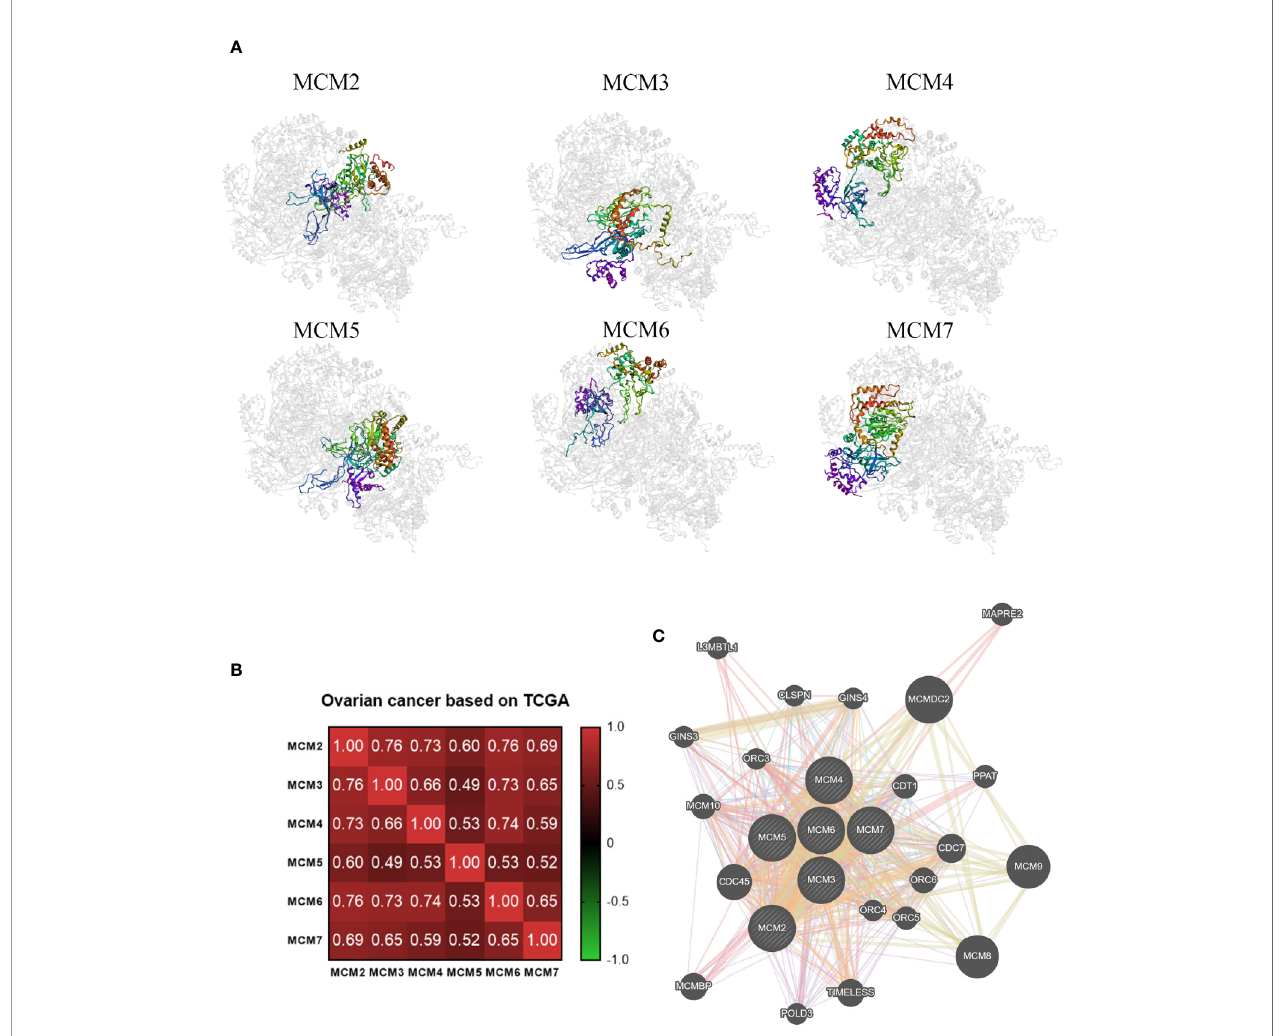
FIGURE 7 | Coexpression and interactions with MCM complex. (A) The tertiary structure of MCMs based on the PDB database. (B) Spearman ’ s correlation analysis of the MCMs. (C) The protein – protein interaction network among the MCM members based on the GeneMANIA